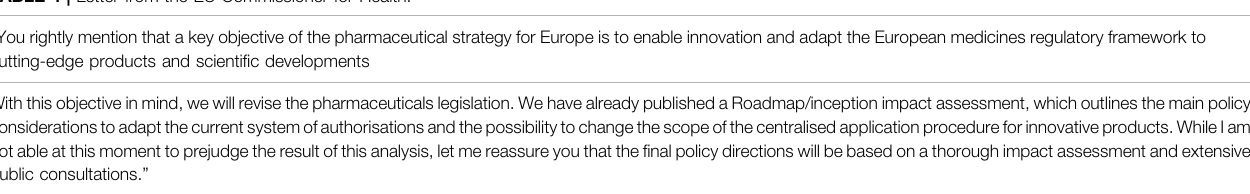
TABLE 4 | Letter from the EU Commissioner for